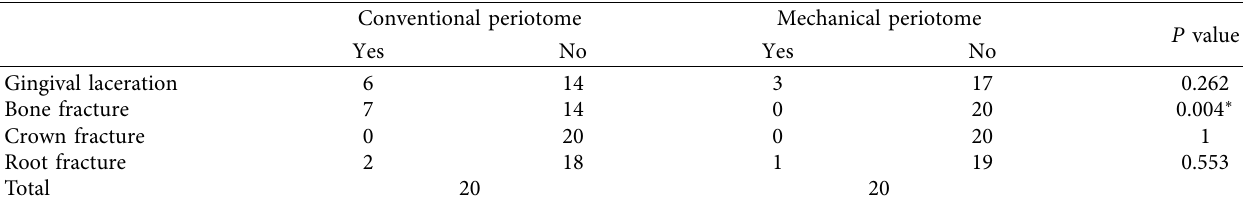
Table 1: Comparison between the conventional and mechanical periotome in relation to gingival laceration, bone fracture, and crown and root